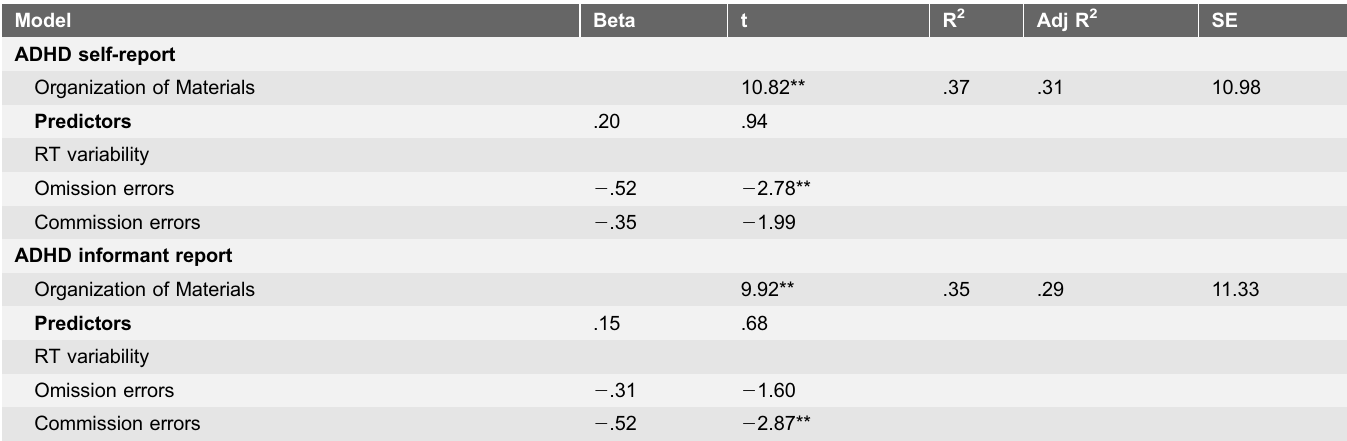
Table 6. Summary of multiple regression models predicting ADHD self- and informant report scores on the BRIEF-A Organization of Materials scale from the patients’ T.O.V.A. reaction time variability, omission- and commission